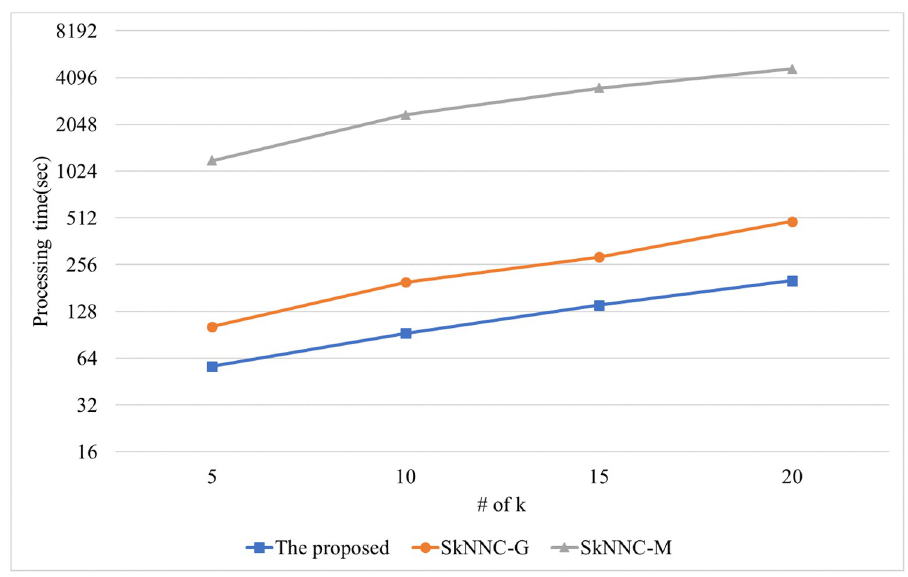
Fig 11. Processing time with varying